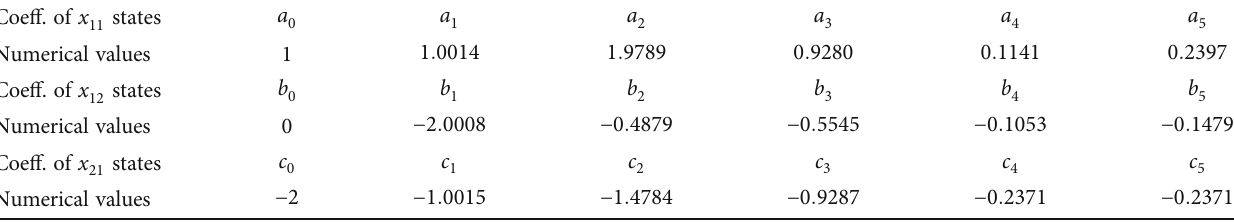
ð t Þ , x ð t Þ , x ð t Þ . 11 12 13